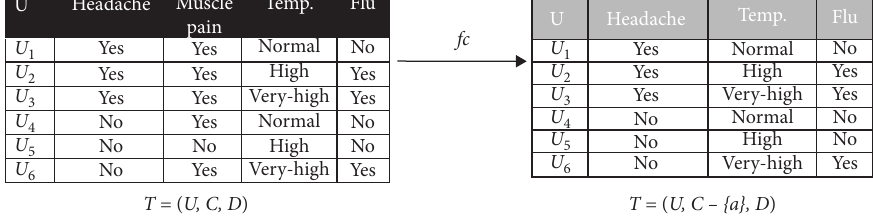
Figure 1: Some reductions of information system by projection function.